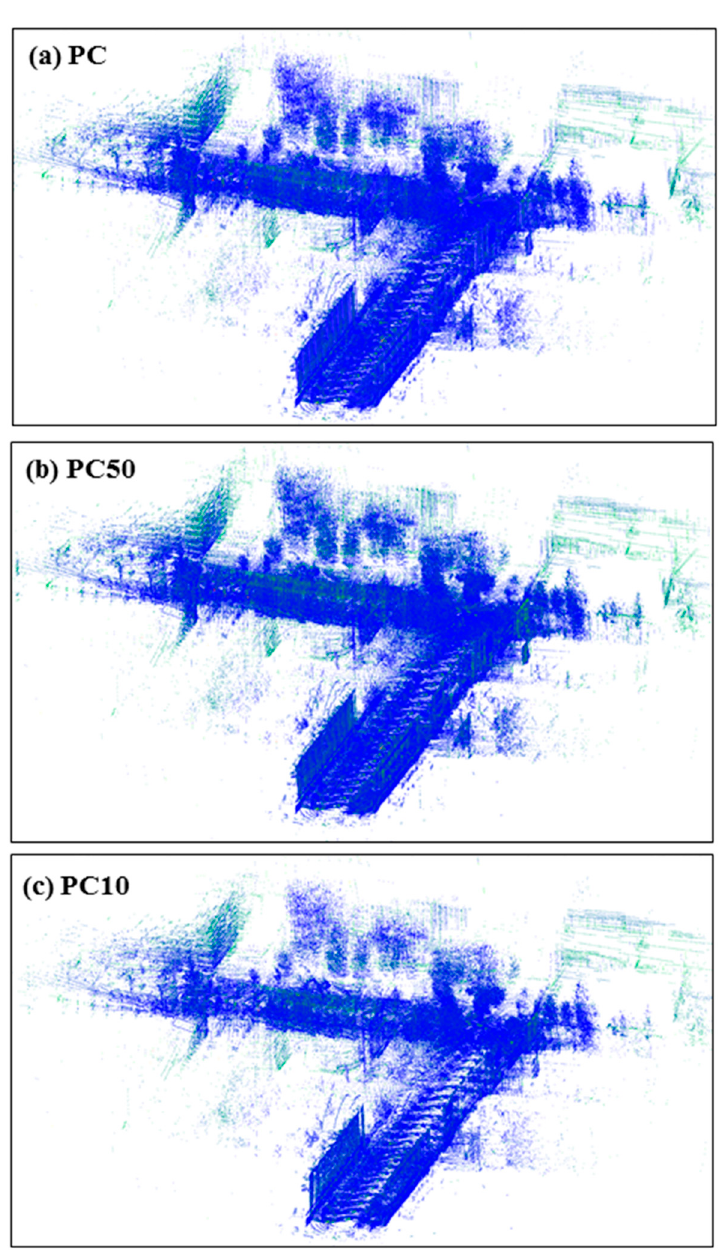
Figure 9. 3D point cloud ( a ) original; ( b ) 50% of points in PC after reduction; ( c ) 10% of points in PC after reduction.